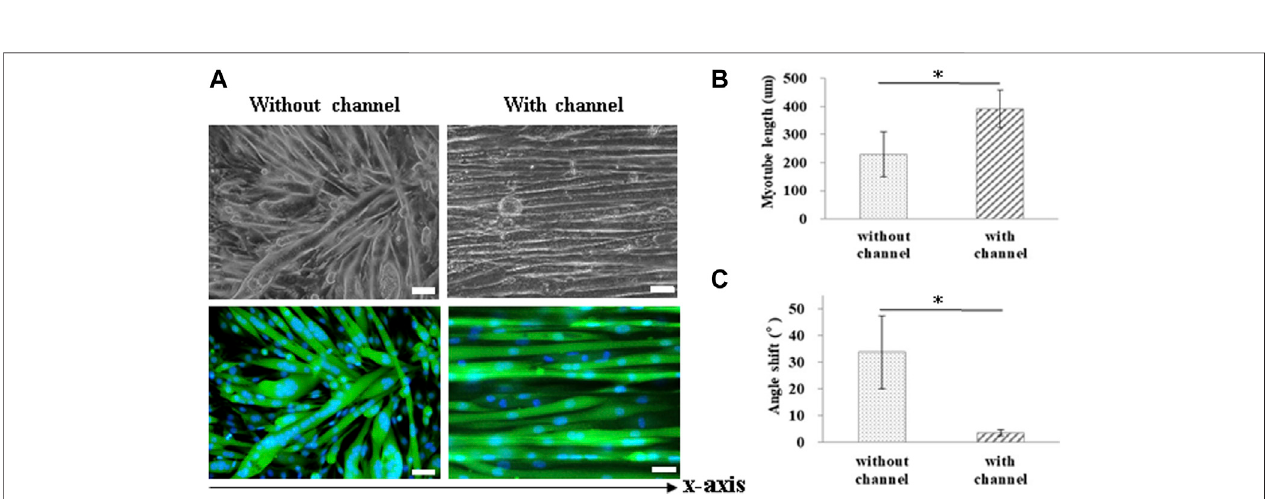
FIGURE4| MeasurementofmyotubealignmentonmicrochanneledGSscaffold.Themyotubeswerealignedalongthemicrochannels7 daysafterdifferentiation. (A) The morphology of the myotubes and myosin immunostaining (scale bar = 50 μ m). The quanti fi cation of the (B) myotube length and (C) angle shift using ImageJ software. The control group comprised cells cultured on the GS scaffold without microchannels. Data are presented as the mean ± SD, n = 20, in two independent experiments, * p < 0.05.